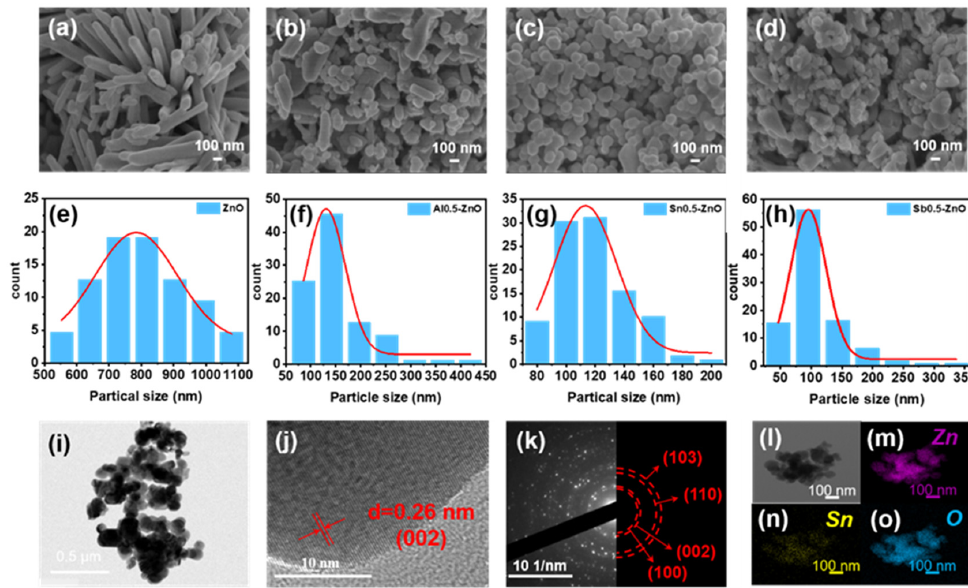
Figure 2. ( a – d ) FESEM images of ZnO, Al0.5-ZnO, Sn0.5-ZnO, and Sb0.5-ZnO, respectively. ( e – h ) particle size count images of ZnO, Al0.5-ZnO, Sn0.5-ZnO, and Sb0.5-ZnO, respectively. ( i ) TEM, ( j ) HRTEM images, ( k ) SAED pattern, and ( l – o ) EDX mapping of the